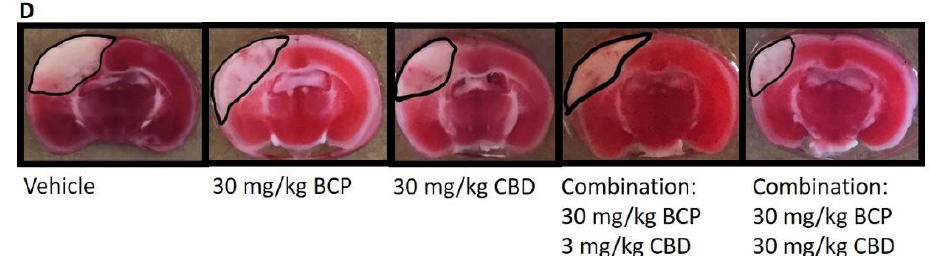
Figure 1. Beta-caryophyllene (BCP), cannabidiol (CBD) and BCP + CBD combinations significantly reduced infarct size in a mouse model of permanent ischemia (photoinjury). X axis: treatment (all mice exposed to photothrombosis and either vehicle or a dose of BCP, CBD, or their combination), Y axis, infarct area in mm2. ( A ) BCP treatment led to a significantly smaller infarct size as compared to vehicle treatment (* p = 0.005). ( B ) CBD treatment led to a significantly smaller infarct size as compared to vehicle treatment (* p = 0.018). ( C ) BCP + CBD treatment led to a significantly smaller infarct size as compared to vehicle treatment (* p = 0.001). Data are expressed as mean and SEM and were analyzed utilizing one-way ANOVA with Dunnett’s multiple comparison test. ( D ) The center of the lesion is in parietal cortex area 1 at approximately –2.0 mm from Bregma. The infarct size is measured with TTC staining. BCP treatment led to more shallow but broader damage, CBD treatment led to a narrower but deep, infarct, and the combinations combined these two characteristics with a more narrow and shallow range of damage.